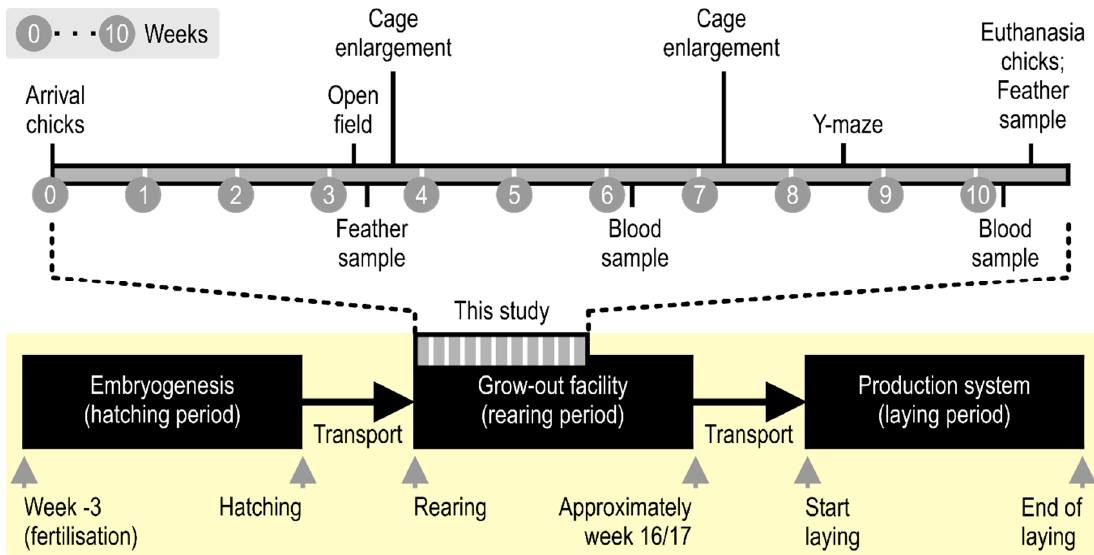
Figure 1. The production of the laying hen consists of three phases that take place in different facilities. After embryogenesis, one-day-old chicks (after hatching) are moved to the grow-out facility for the rearing period. Here they are kept until approximately week 16/17, when they start laying eggs, and are moved to the production system for the laying period. This study addresses the first 10 weeks of the rearing phase.